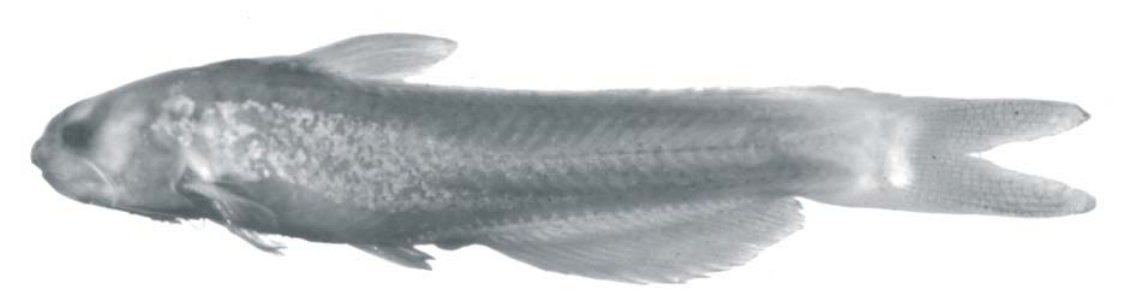
Fig. 1. Cetopsidium ferreirai , new species, holotype, male, INPA 10194, 25 mm SL; Brazil, Pará, rio Trombetas basin, rio Mapuera, last cachoeira before the rio Trombetas (approximately 1°05’S,